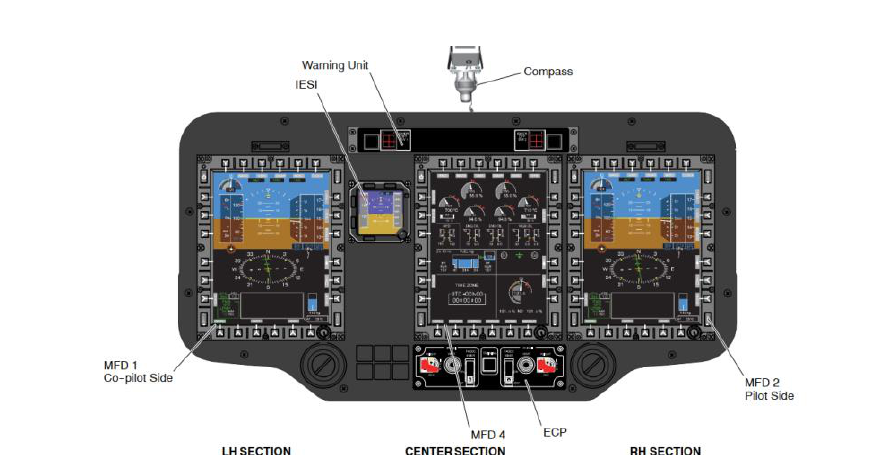
Figure 3 – Layout of multifunctional indicators of the H-145M helicopter Рис. 3 – Компоновка многофункциональных индикаторов вертолета H145M Слика 3 – Распоред мултифункционалних индикатора хеликоптера Х-145М The desired data displayed on multifunctional indicators